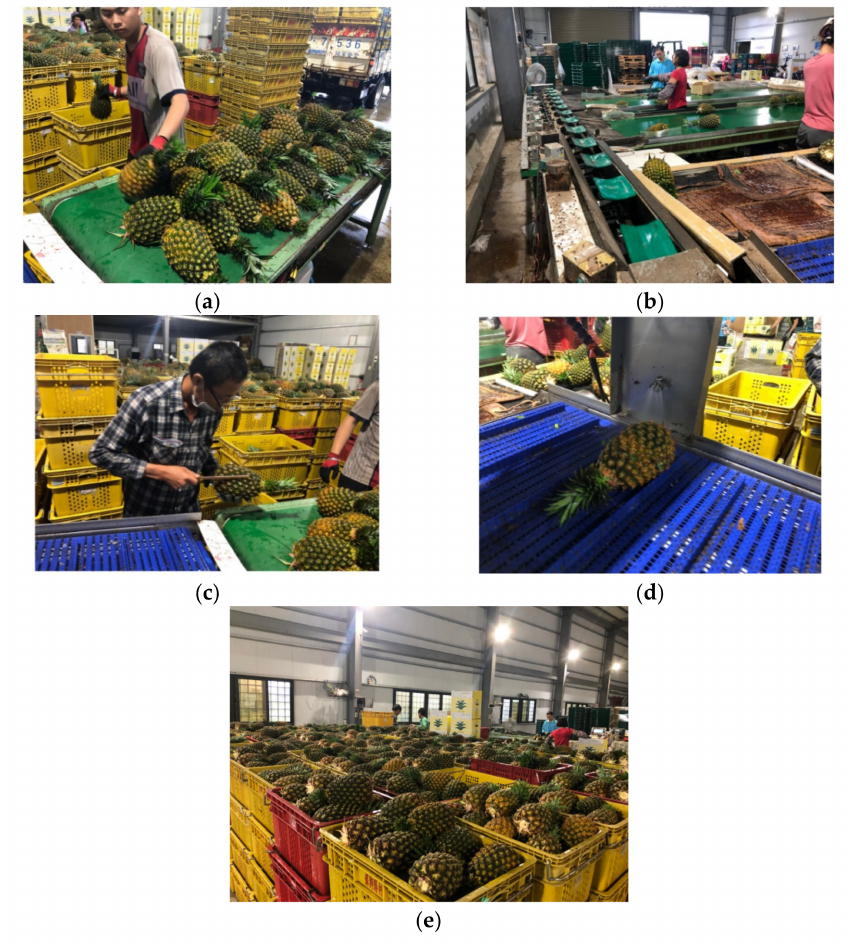
Figure 1. Time and resource-consuming classification of pineapples; ( a ) transportation, ( b ) conveyor classification by weight, ( c ) sound test classification, ( d ) cleaning, and ( e ) final classified